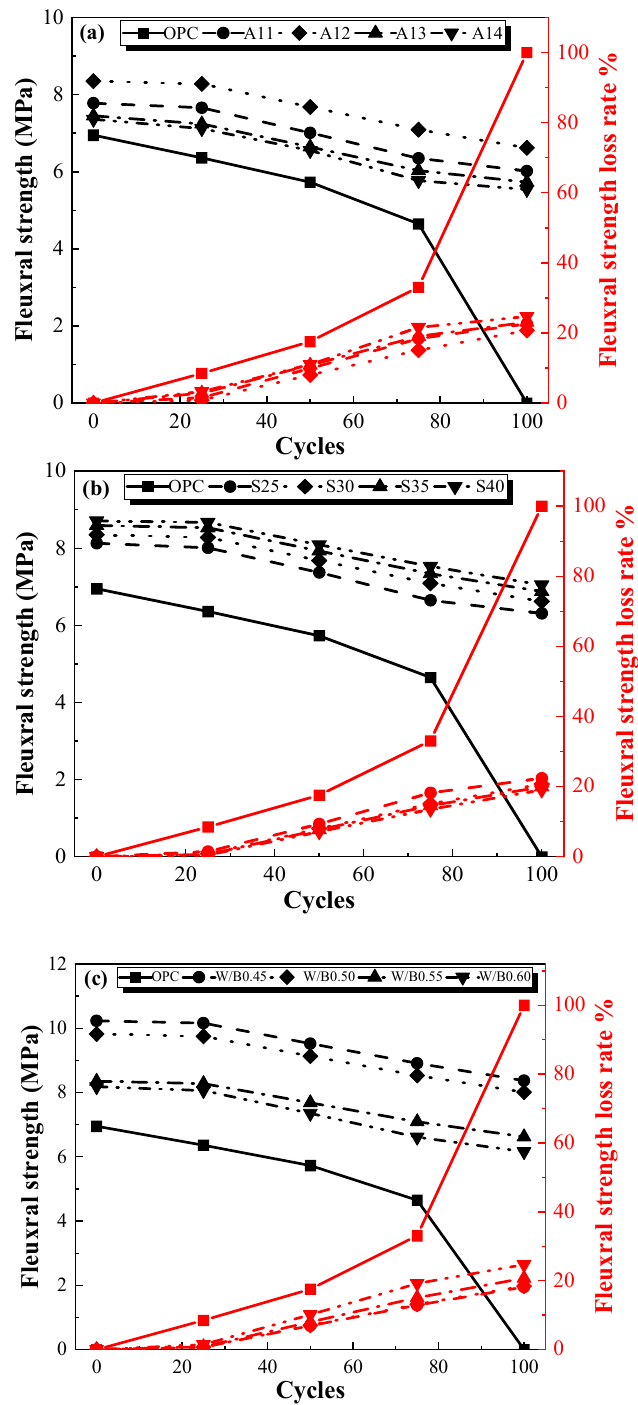
Figure 6. Effects of ( a ) alkali content, ( b ) slag content, and ( c ) water-to-binder ratio on the flexural strength of specimens.